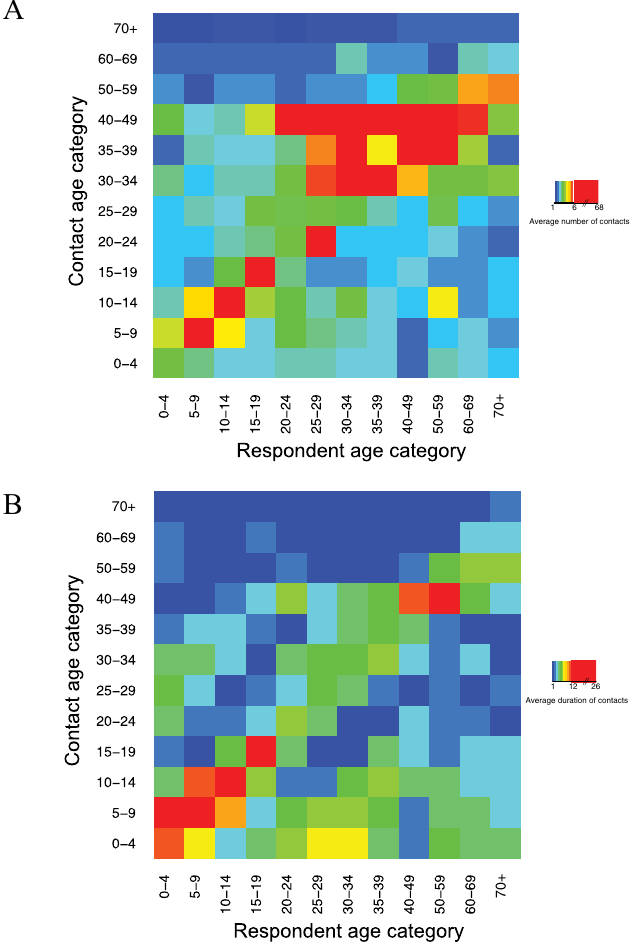
Fig 1. Average number of contacts reported by respondents with contacts of each age-group (A). Average number of person-hours spent by respondents in contact with people of each age-group (B).